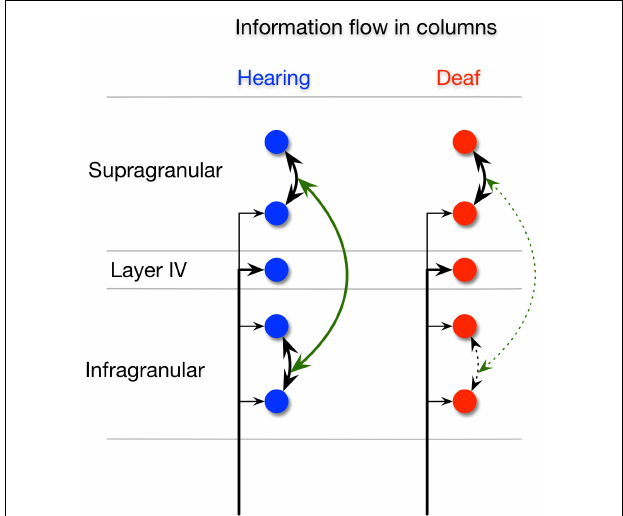
FIGURE 6 | Intrinsic information flow in the hearing and deaf animals. Illustration of intrinsic information flow between supragranular and infragranular layers in the hearing animals (left), (blue) showing normal strong supra-supra, infra-infra, and supra-infra interactions. Congenitally deaf animals (right), (red) show normal supra-supra interactions but significant deficits in the supra-infra and infra-infra